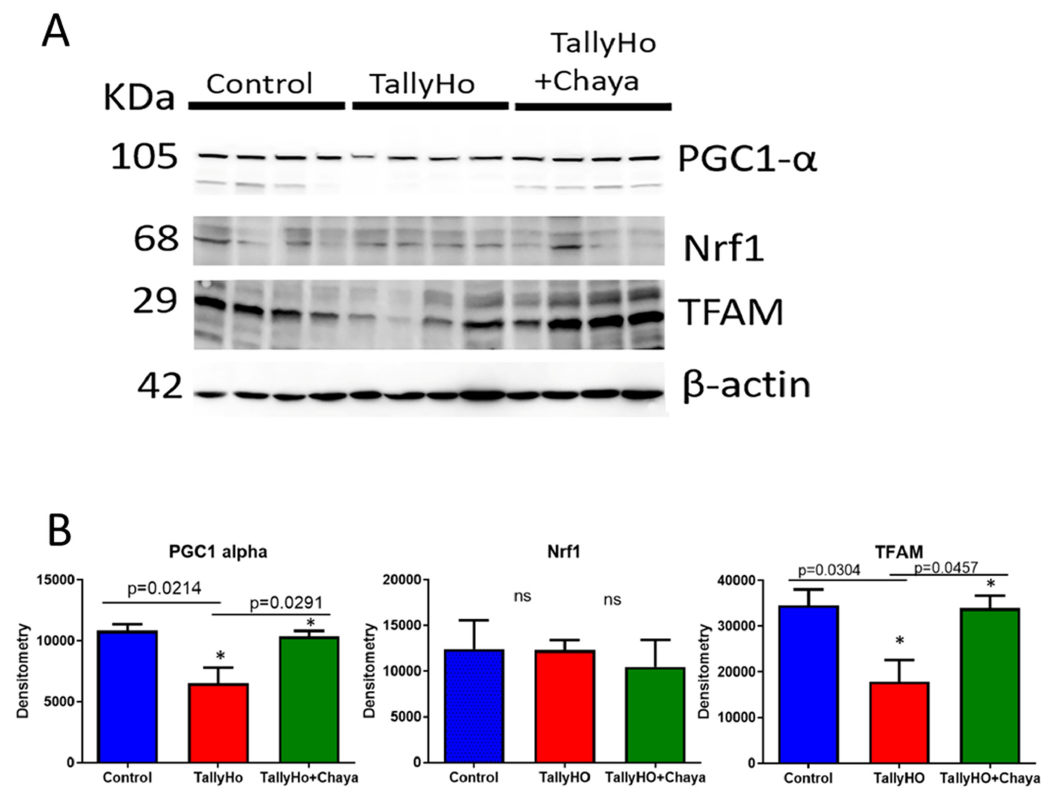
Figure 4. Immunoblotting analysis of mitochondrial biogenesis proteins using protein lysates ob- tained from the post-mortem brains of 14-month-old non-diabetic control mice, TH mice fed with chaya, and TH mice fed with regular chow (for each of the three groups, n = 4). ( A ) Immunoblots for the control, TH, and TH + chaya mice. ( B ) Quantitative densitometry analysis for the mitochondrial biogenesis proteins PGC1 α and TFAM, which were significantly decreased in the TH mice compared to the control mice (PGC1 α , p = 0.0214 and TFAM, p = 0.0304), but the PGC1 α and TFAM levels were significantly increased in the TH + chaya mice at levels comparable to the control mice (PGC1 α , p = 0.0291 and TFAM p = 0.0457). No significant change was seen in the expression level of Nrf1 in the TH mice compared to the control mice. * p = 0.01.